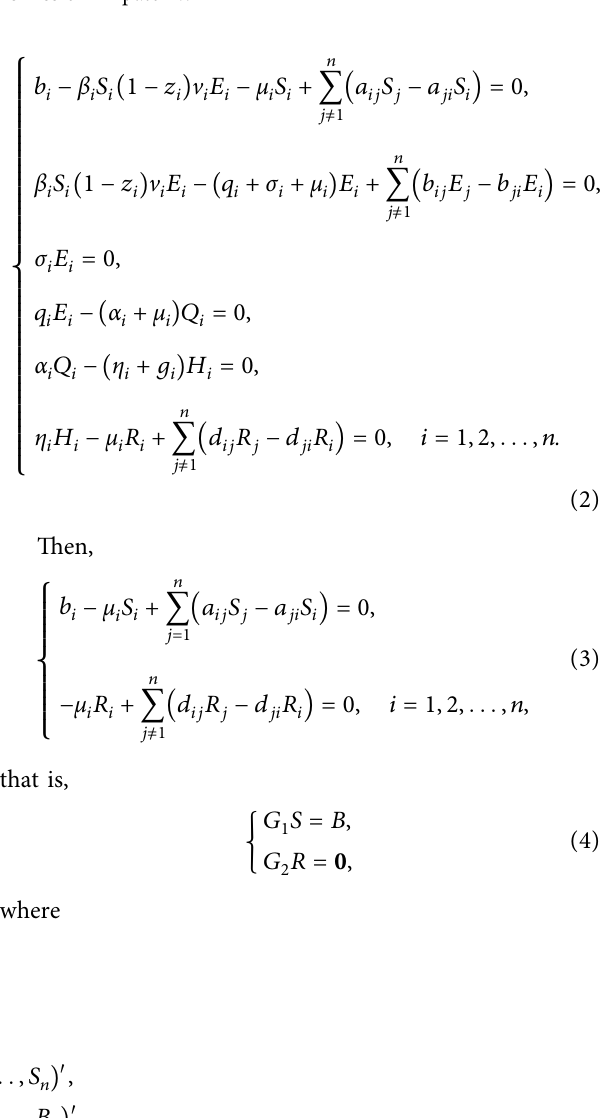
Figure 1: The disease transmission in patch i